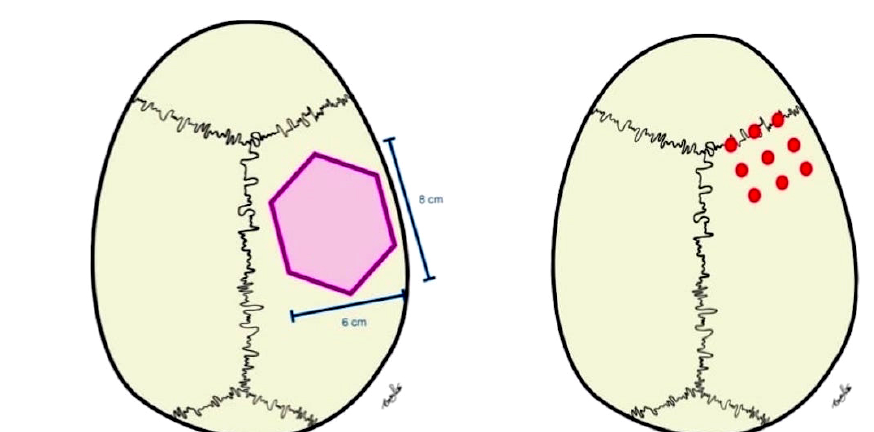
Figure 5- Illustration of the donor site of hexagonal shape described in the study by De Ceulaer, et al. 31 (2012). Illustration of the 9 points where the measurements were